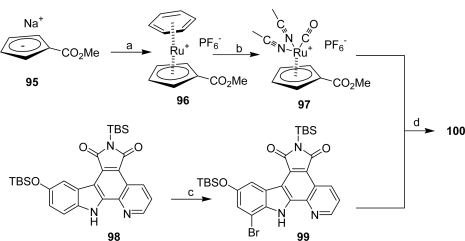
(a) [(C6H6)RuCl2]2. (b) (1) hν, MeCN, (2) CO.(c) PhMe3NBr3, rt. (d) (1) K2CO3 (2) TBAF.